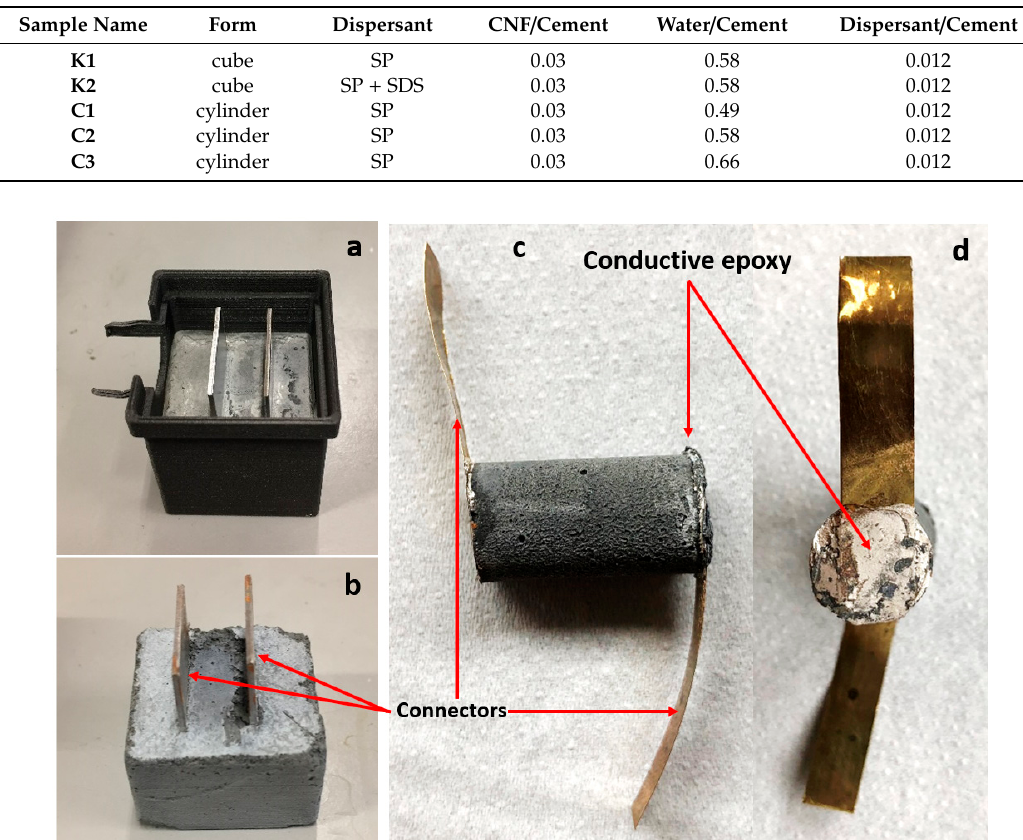
carbon nanofibers (CNFs), water, dispersant and cement for each sample.